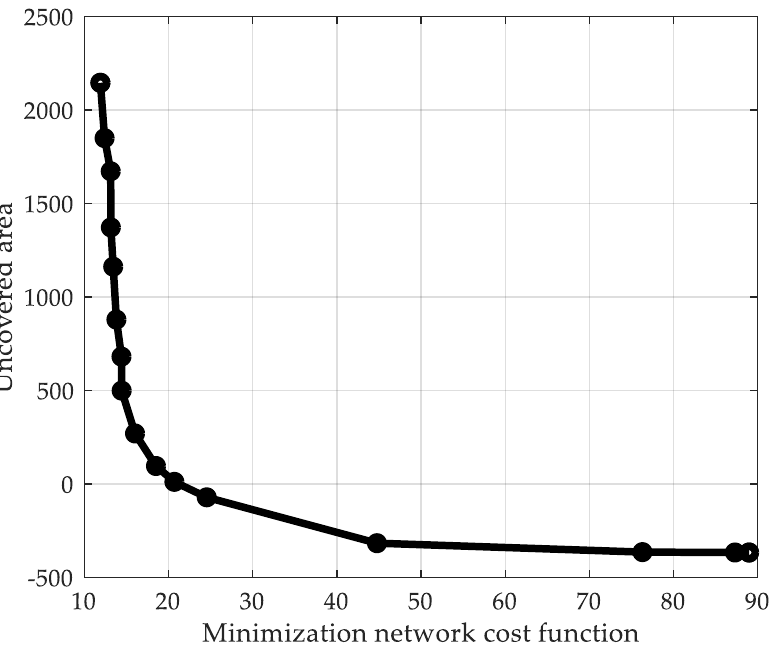
Figure 10. Value of uncovered area and minimization network cost value.